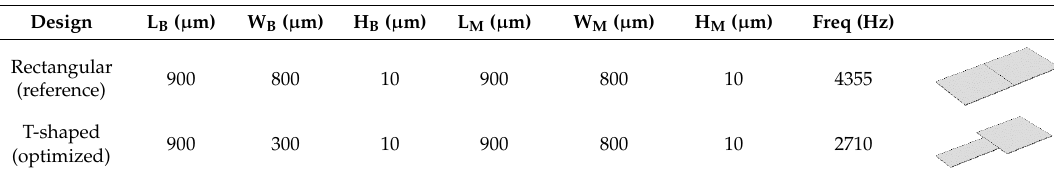
Table 2. Proposed Design Parameters.